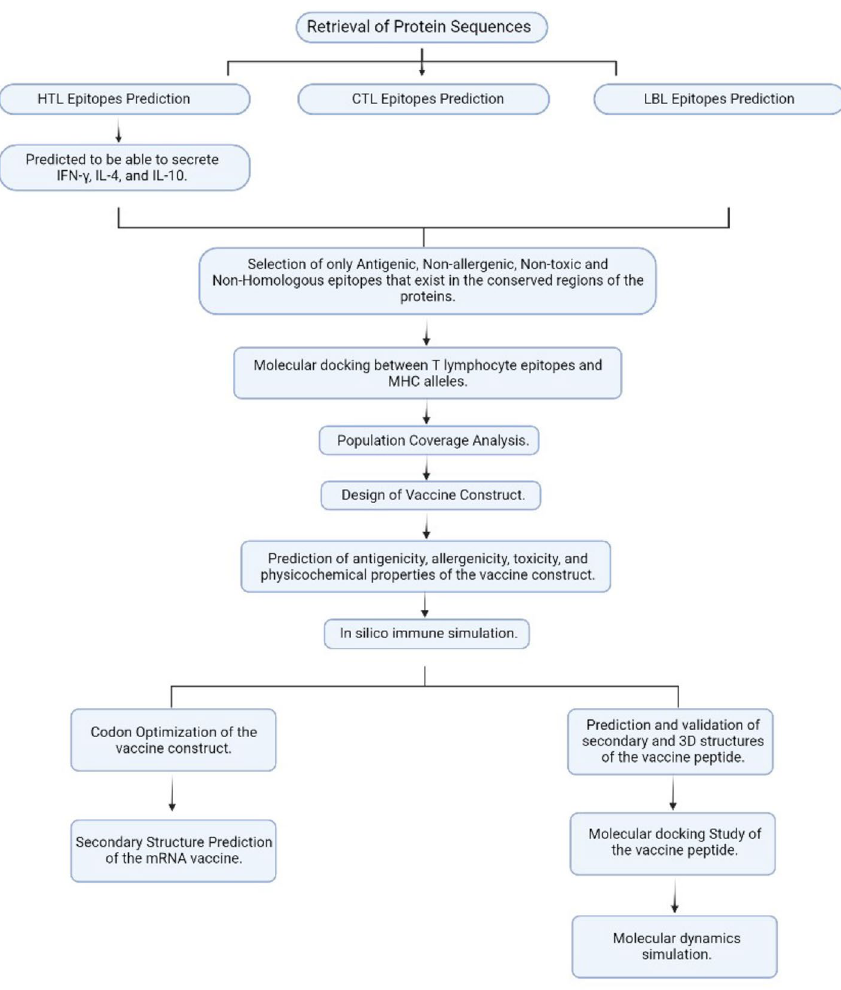
Figure 10. Workflow of RABA_MARZ_14.5.9 mRNA vaccine